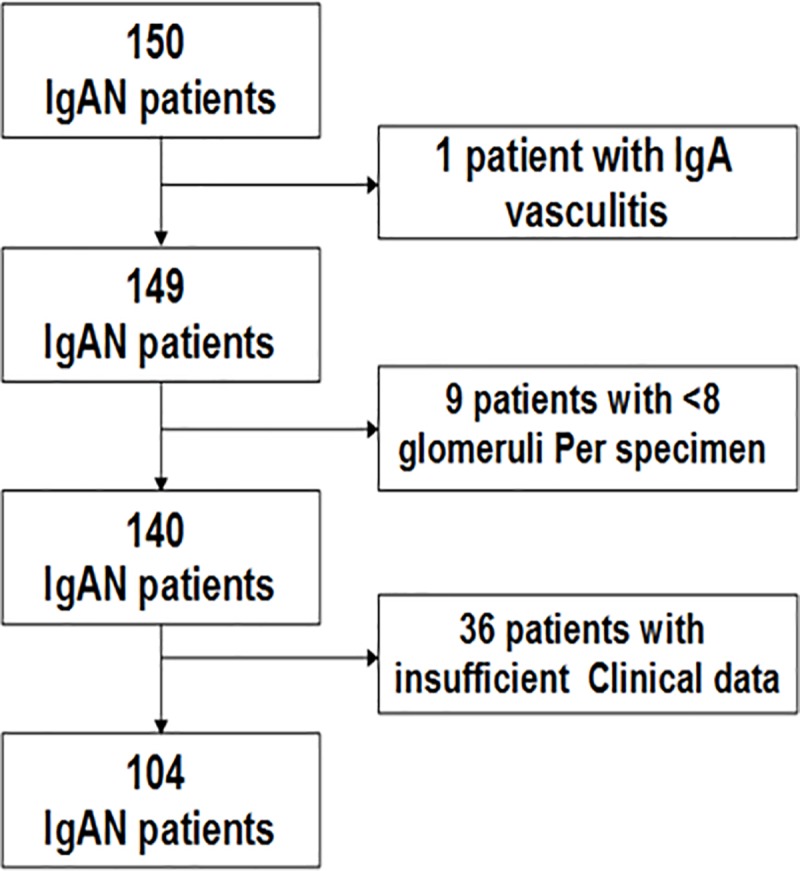
The flowchart shows the number of IgAN patients excluded from the cohort study.